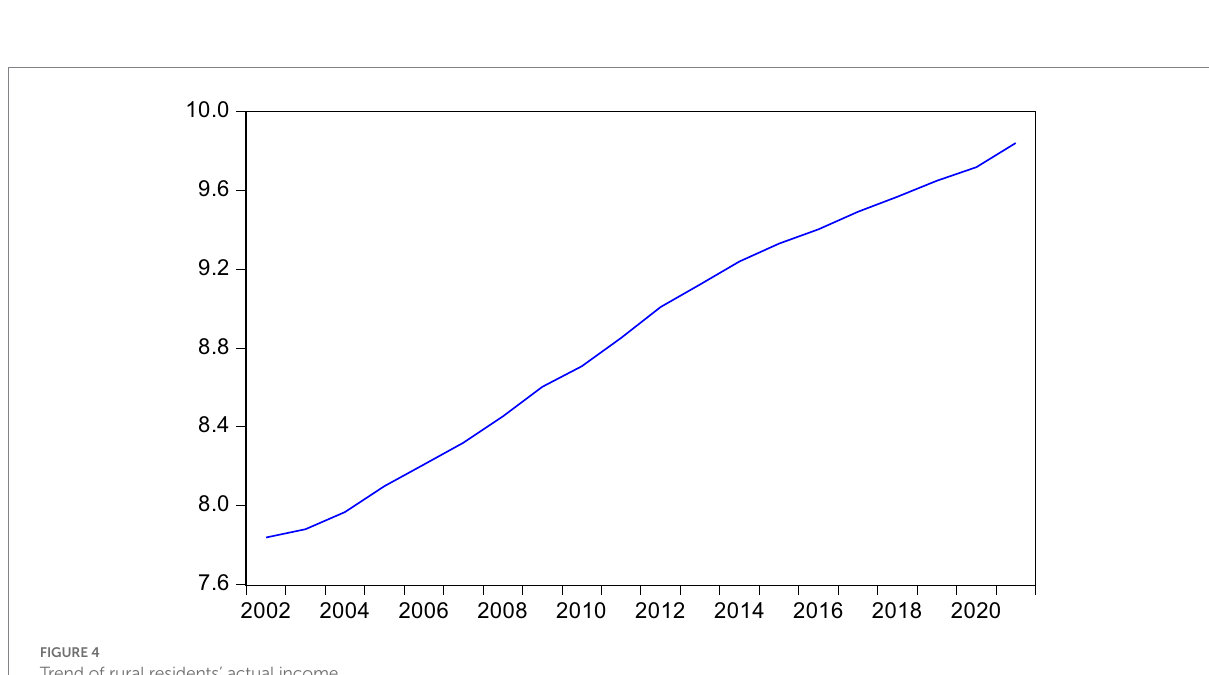
FIGURE 3 Trend of rural residents’ actual consumption.